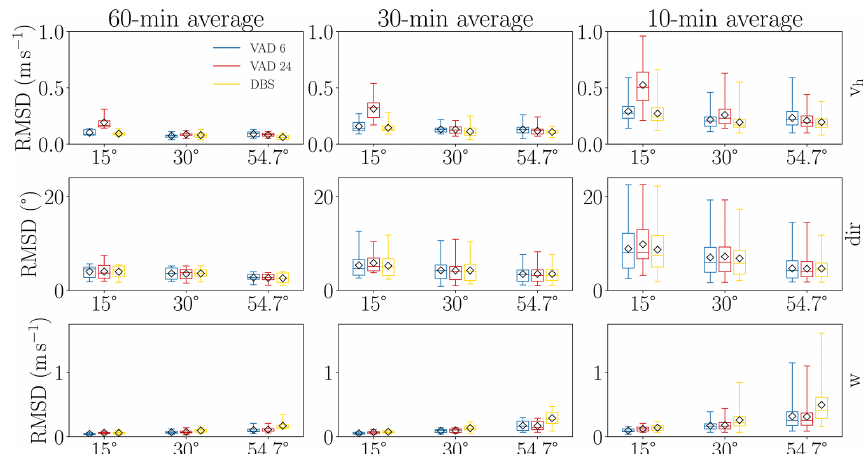
Figure 9. Ensemble case 1: RMSD of virtual lidar measurements of wind speed, wind direction and vertical wind with reference to the respective “true” wind profile above the lidar. RMSD values were calculated over a height interval extending from 50 to 960m for measure- ments averaged over different time intervals. Results are grouped by zenith angle configuration (15, 30 and 54.7 ◦ ). Different colors denote different scan techniques (VAD 6, VAD 24 and DBS). Whiskers indicate the entire range of values, including the maximum and minimum. In addition, mean values are marked by a black diamond.